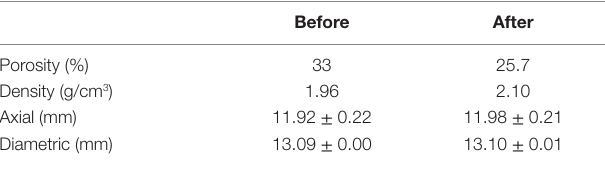
TaBle 2 | Density, porosity, and dimensions before and after 12-day “solution replacement” reaction via rhlPD